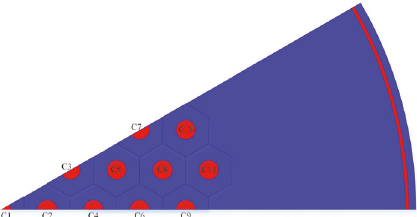
Figure4:Thecross-sectionalviewofthe1/12coreofthe2MW-MSR.